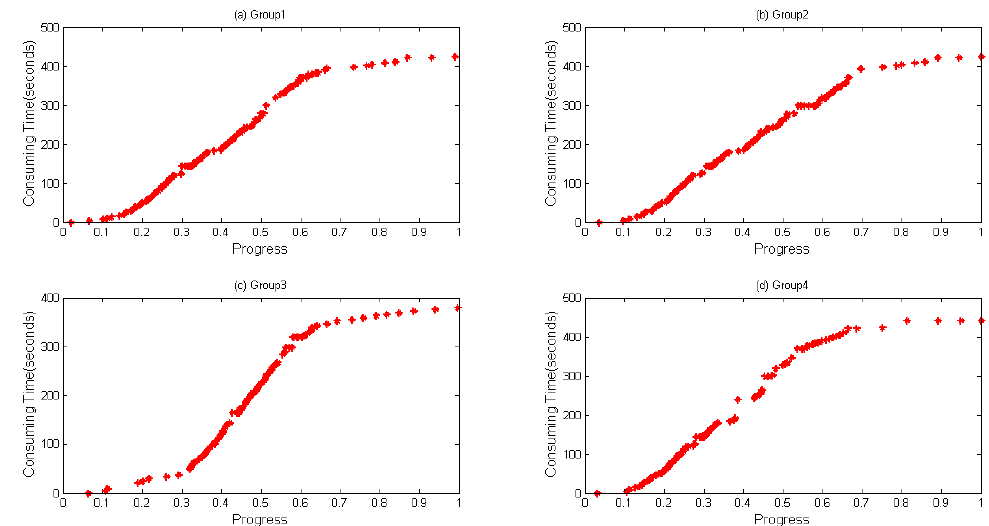
Figure 3. Data collected during running Sort on the same node. Different groups of data generated from four map tasks running on the same node when executing Sort: ( a ) Group 1; ( b ) Group 2; ( c ) Group 3; and ( d ) Group 4.